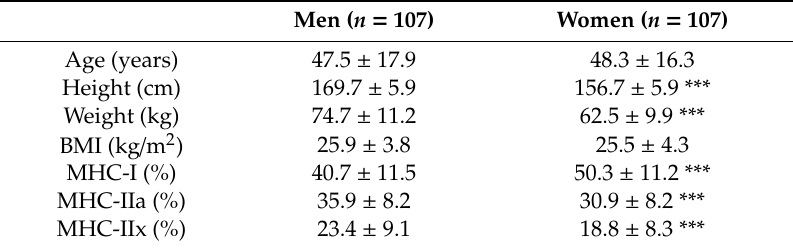
Table 1. Characteristics of the subjects.